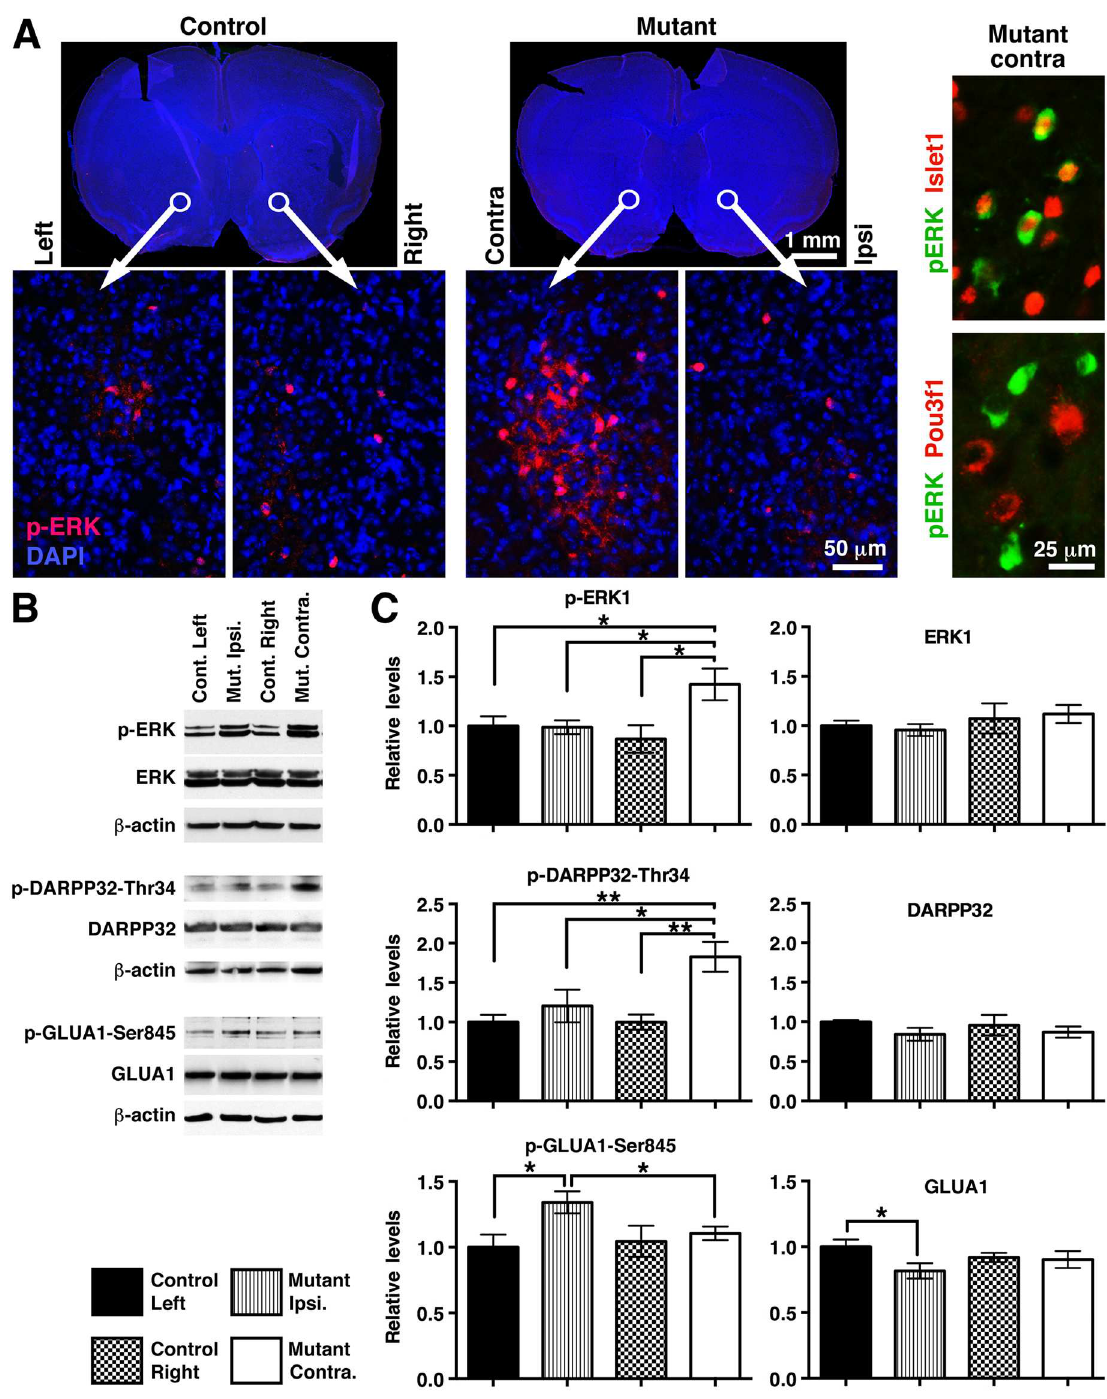
Fig 3. Molecular asymmetries in striatal hemispheres correlate with preferred turning direction in Slc12a2 K842 (cid:3) /K842 (cid:3) mice. (A) Left panels: p-ERK immunostaining within the nucleus accumbens. Right panels: costaining of the mutant ventral striatum on the contralateral side with anti–p-ERK and anti-Islet1 or anti–p-ERK and anti-Pou3f1. (B) Western blots of striatal protein. β -actin, loading control. (C) Western blot quantification. Values are normalized to β -actin. (cid:3) = p < 0.05; (cid:3)(cid:3) = p < 0.005. Mean ± SEM, two-tailed student t test; n = 6 mice per genotype. See also S1 Data. p-ERK, phosphorylated extracellular signal-regulated kinase; SEM, standard error of the mean.